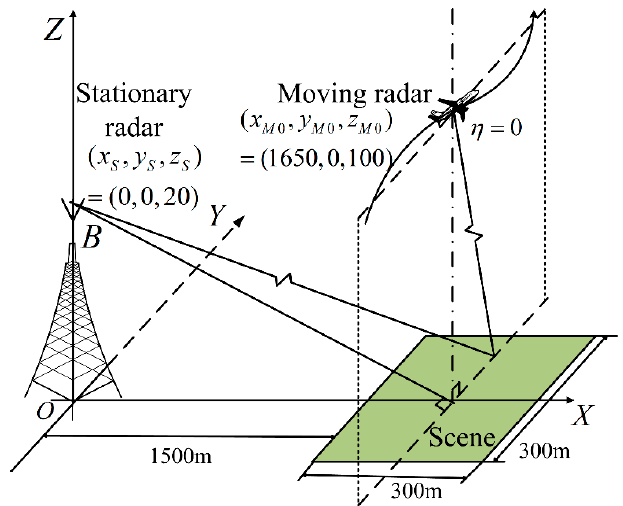
Figure 7. Imaging geometry of the simulated OS-BFSAR system.